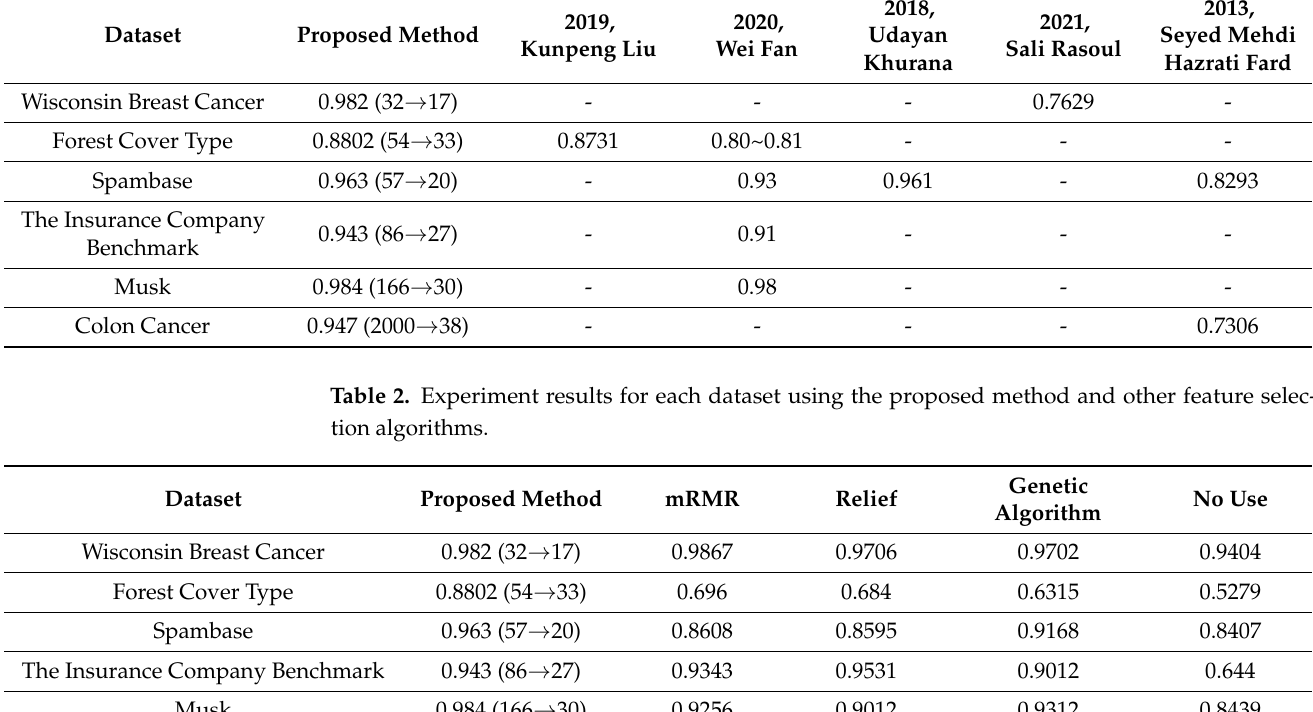
Table 1. Experiment results for each dataset using the proposed method and other RL methods.